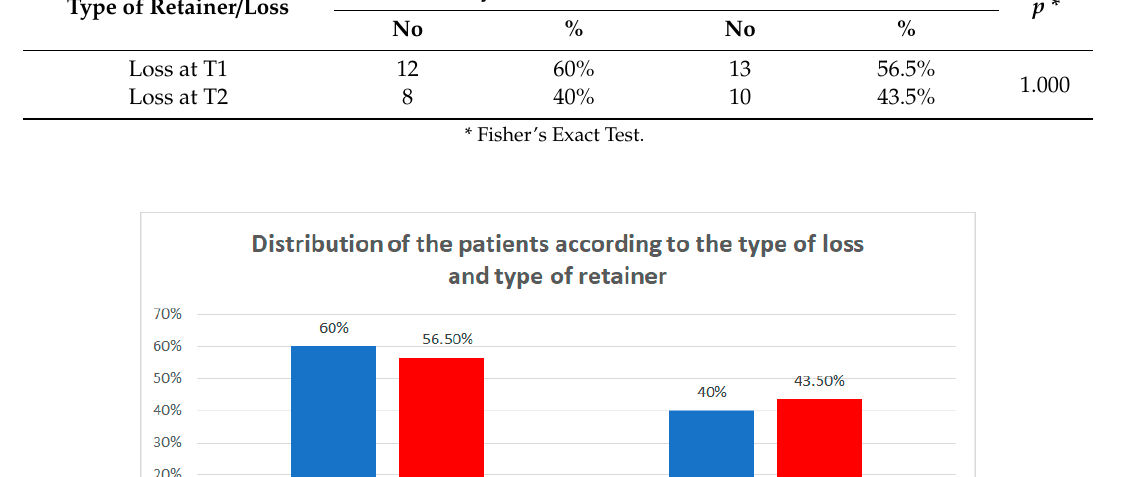
Table 6. Distribution of the patients according to the type of loss and type of retainer.